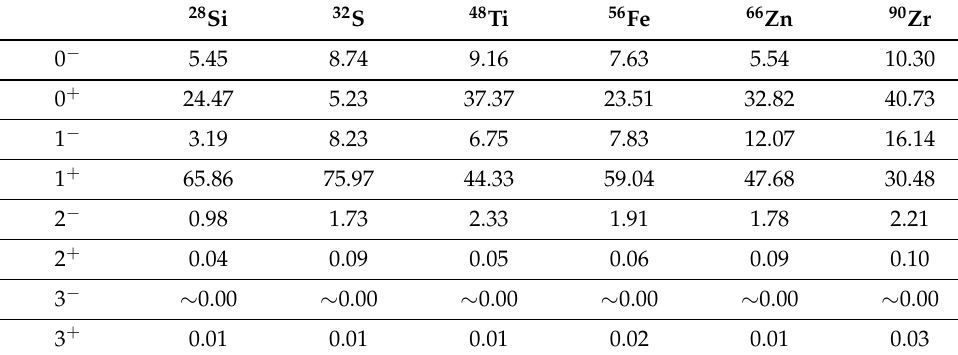
Table 2. The percentages of low-spin multipolarities (up to J π ≤ 3 ± ) into the total e − -capture cross sections, evaluated with our pn-QRPA